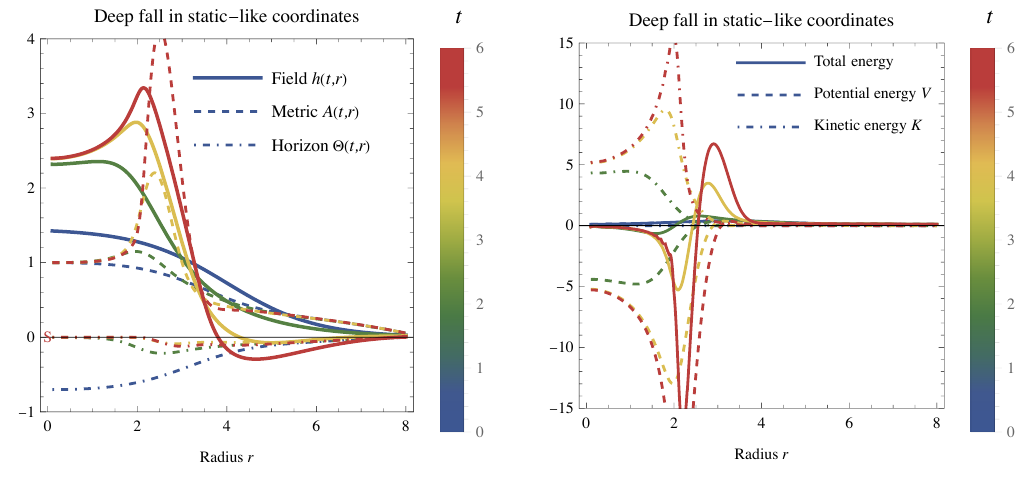
Figure 6 . Evolution in Einstein gravity of a scalar bubble beyond the top of the potential. We work in units in which h = 1 . Left : the field h ( t, r ) , the metric factor A ( t, r ) and the criterion top for horizon formation Θ( t, r ) = − A 2 e 2 δ . Right : the energy